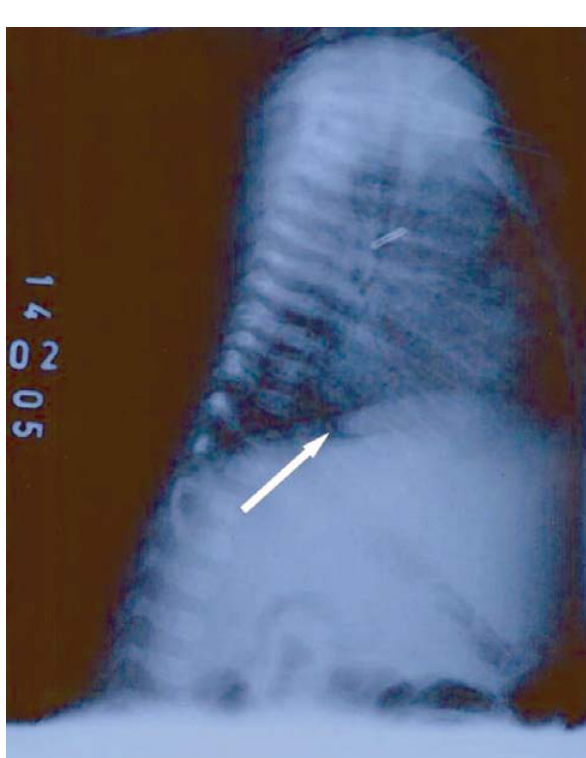
Fig. 1 – Radiografia de tórax com presença de massa em região póstero-inferior